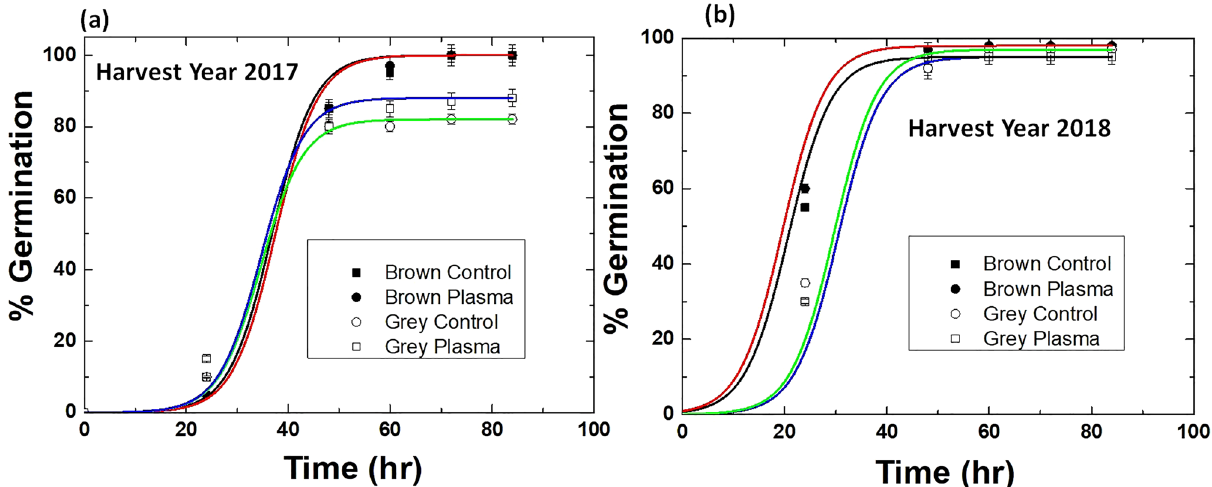
Figure 2. Germination kinetics of brown and grey radish seeds harvested in 2017 (a) and 2018 (b) . The points are fitted using Boltzmann non-linear fit. Brown control (black line), brown plasma (red line), grey control (green line), and grey plasma (blue line).